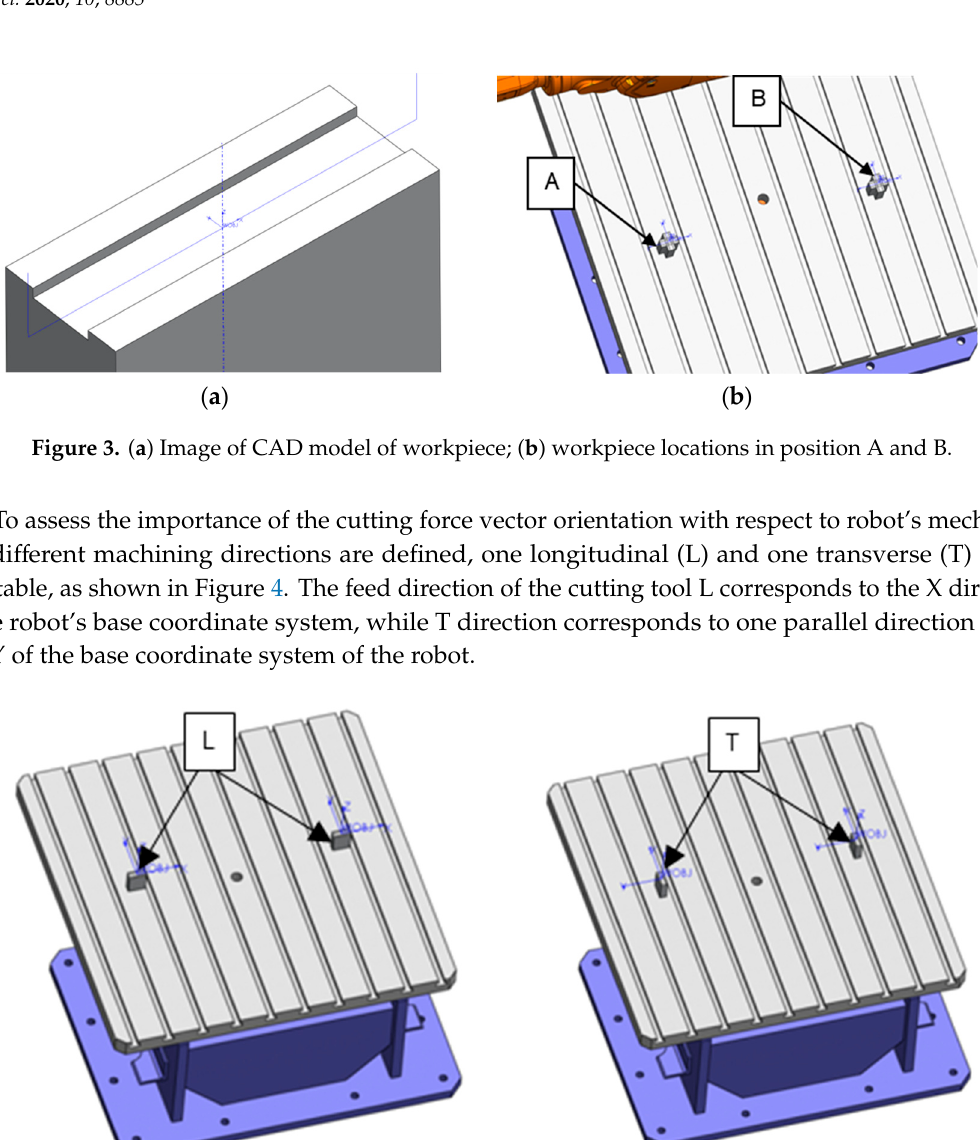
Table 2. Factorial design of variables.